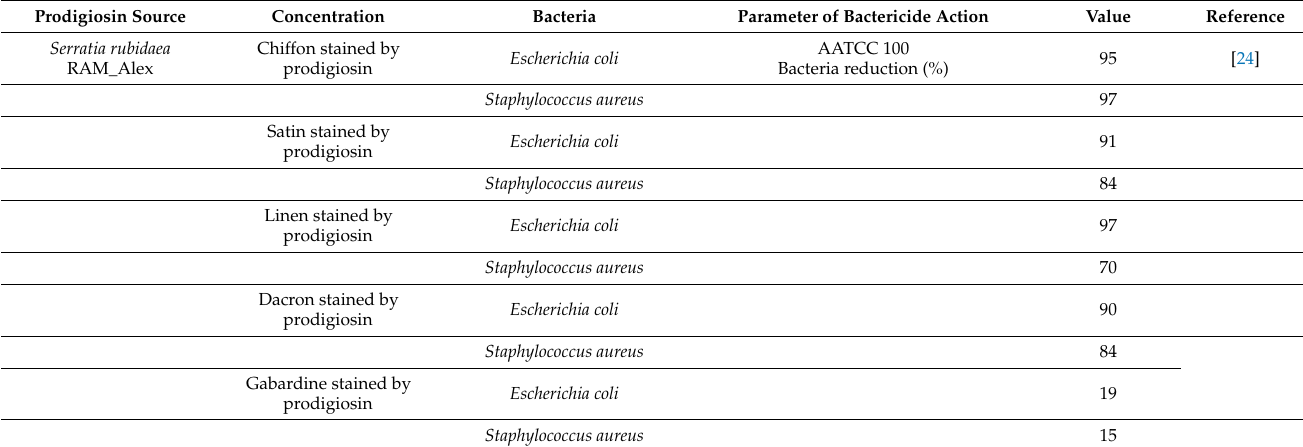
Table 2. Recent antibacterial activity of prodigiosin reported in